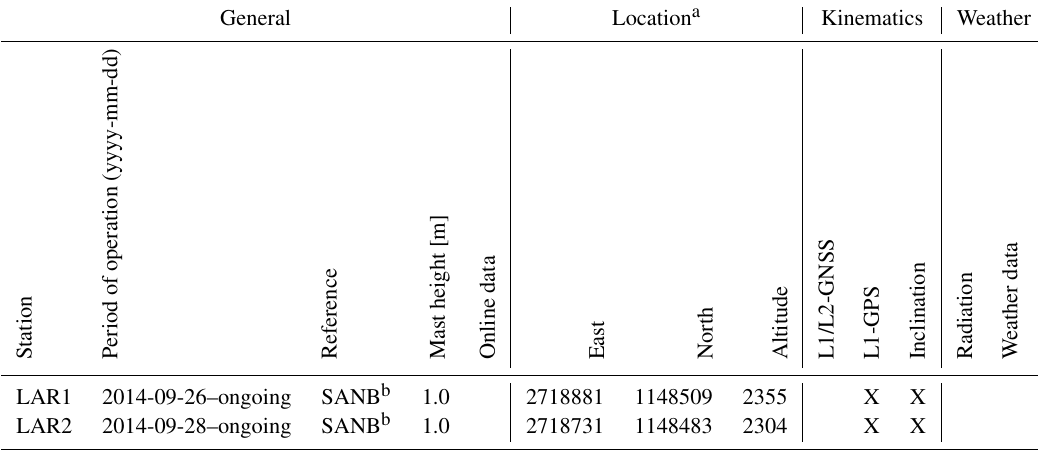
Table A5. Per position overview of the sensors in the Val Blenio field site. General Location a Kinematics Weather